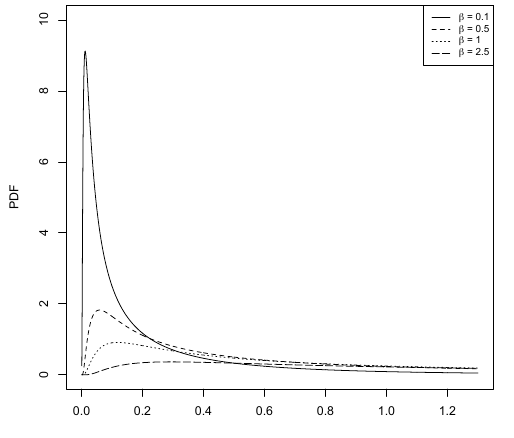
Figure 1. The PDF for the LBS distribution with different values for α and β = 1.